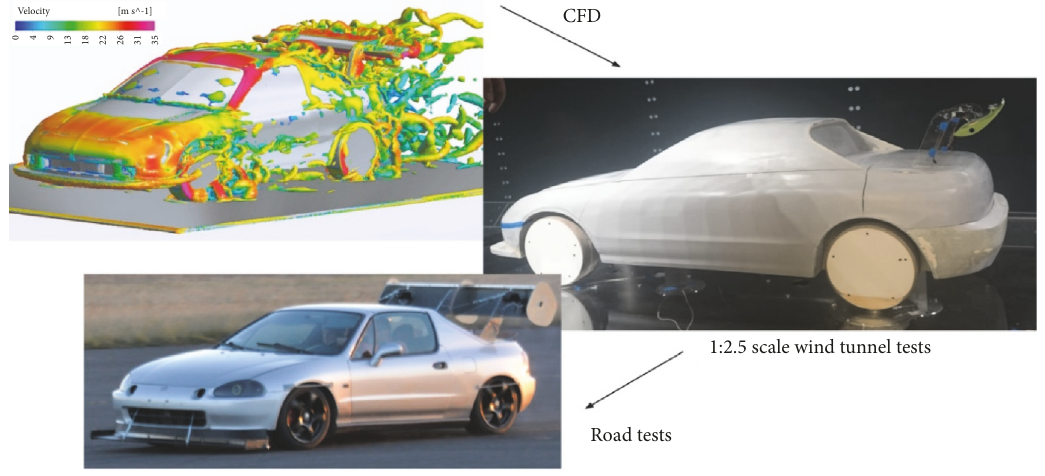
Figure 4: The three different types of aerodynamic